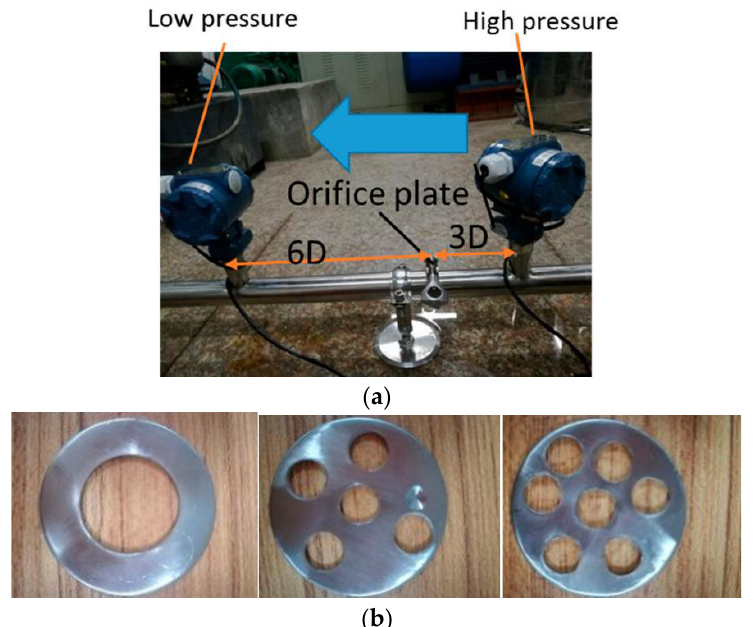
Figure 20. Illustration of the local resistance flowmeter [79]. ( a ) The schematic diagram. ( b )Three sizes for the orifice plate.